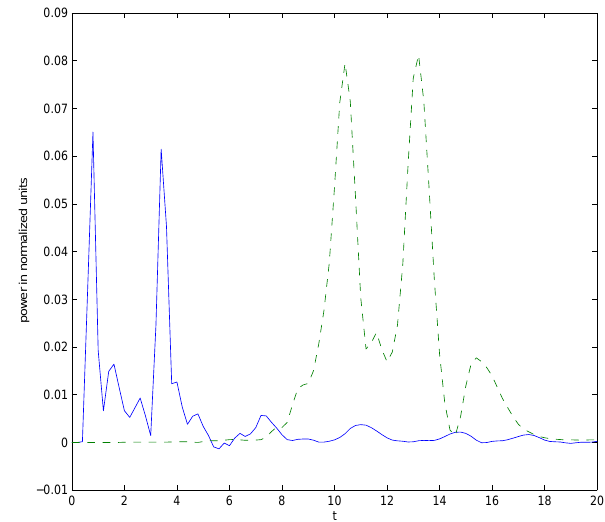
Fig. 5. Top panel: normal velocity of the plasma sheet recorded at x = and z = along time. In order to separate the kink and sausage mode, the half sum (solid line) and the half difference (dashed line) of the velocity field is considered as explain in the text. Bottom panel: power spectrum of the above fluctuations in v z , two harmon- ics compose the kink and sausage fluctuations.